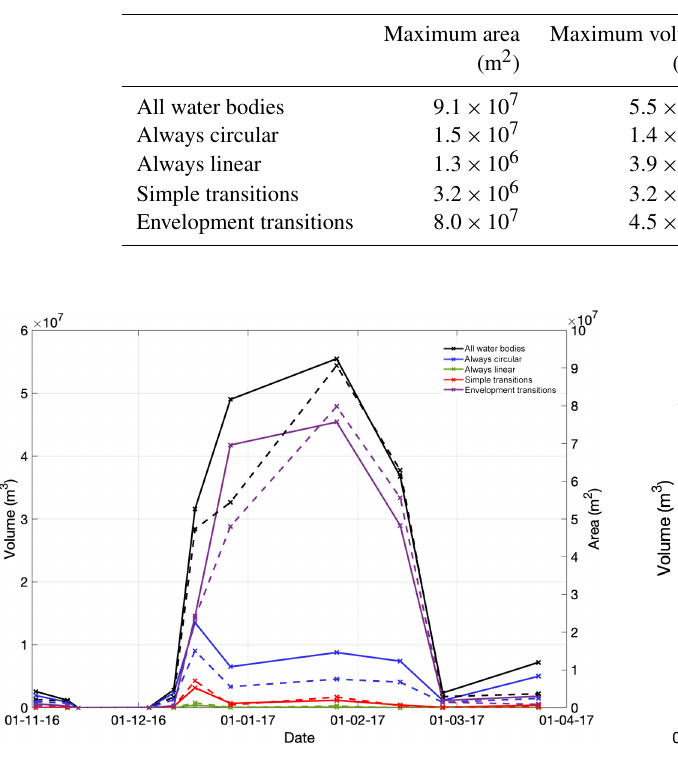
Figure 7. Time series of the total area and volume held in each water body category over the 2016–2017 melt season on the Nivlisen Ice Shelf. Volumes are indicated by the solid lines and areas by the dashed lines.